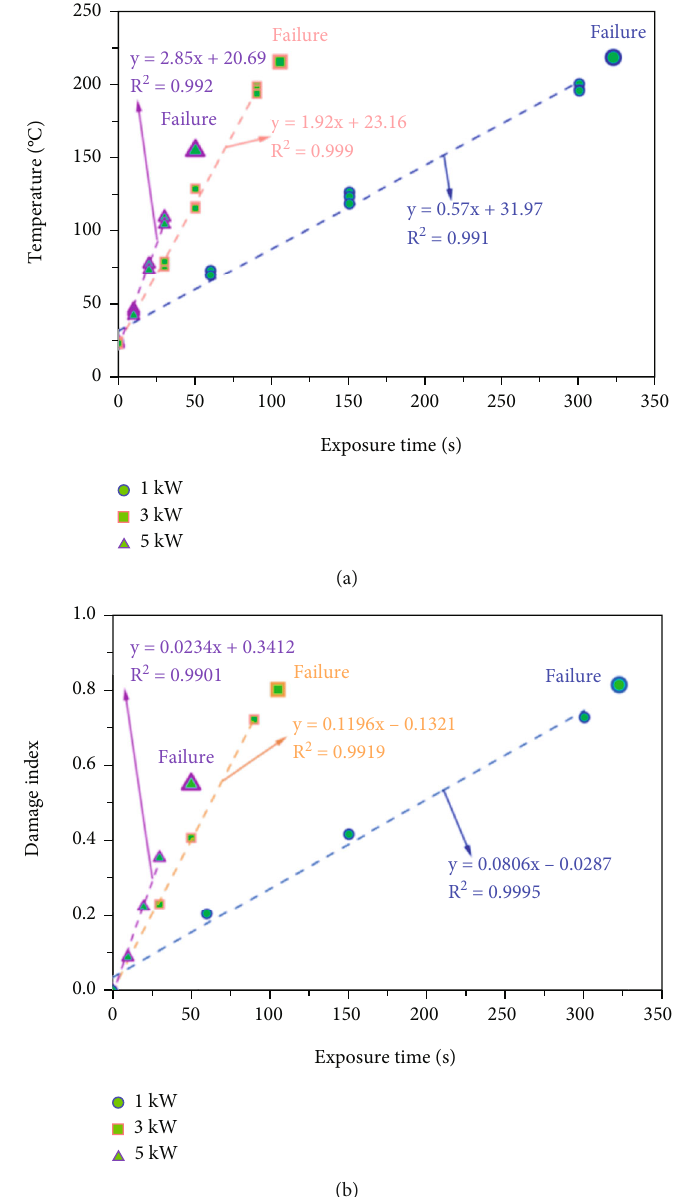
Figure 5: Thermal response induced by microwave irradiation: (a) surface temperature of the basalts and (b) damage index based on the surface